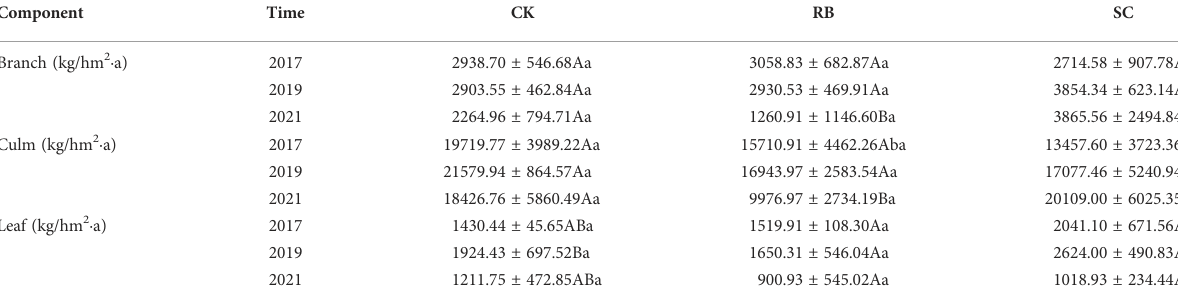
Values are the mean ± standard deviation (n = 3). Different lowercase letters indicate that there are signi fi cant differences in the component productivity of the new bamboo between different treatment plots at the same time (ANOVA and LSD test, p < 0.05); Different capital letters indicate that there are signi fi cant differences in the component productivity of new bamboo in different time at the same treatment plots (ANOVA and LSD test, p <